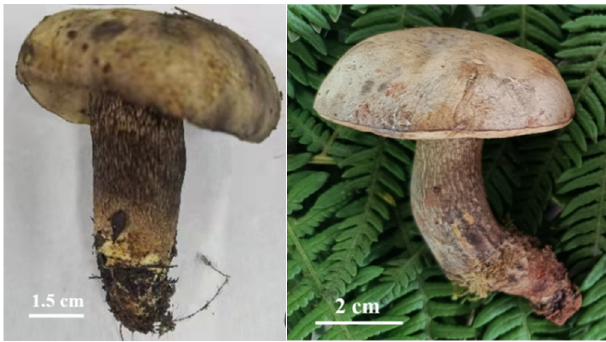
Figure 1. Normal-developed sporocarps of B. griseus .